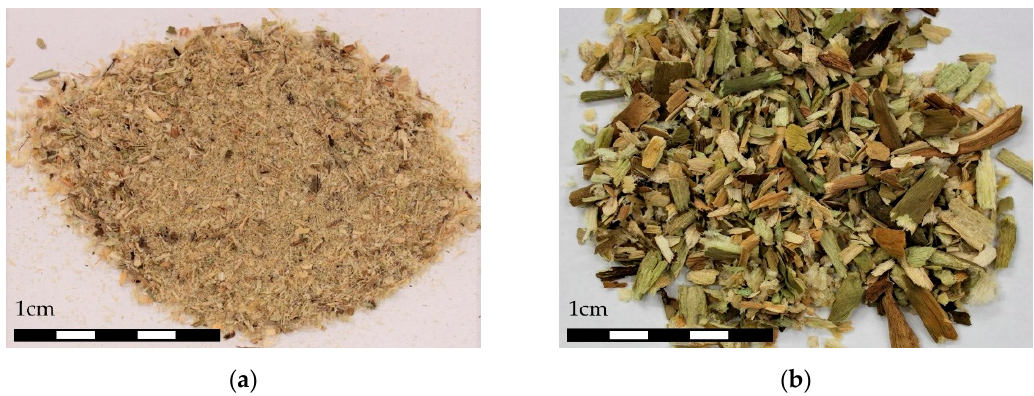
Figure 1. Final Water Hyacinth Petiole (WHP) appearance after the crushing process: pulp ( a ) and staple ( b ).